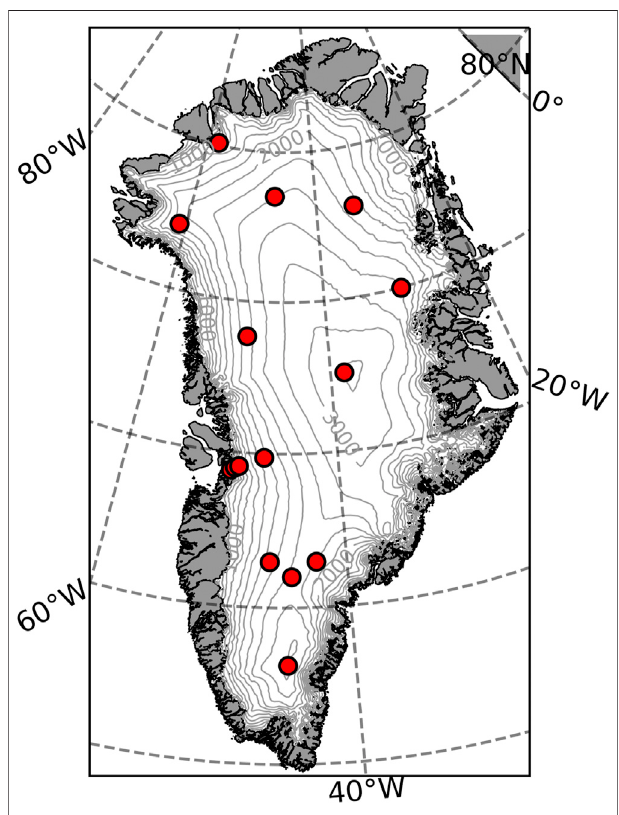
FIGURE 2 | GCNet AWS site locations used in this study. Surface elevation contours in gray are displayed at 200 m intervals (Morlighem et al., 2017).